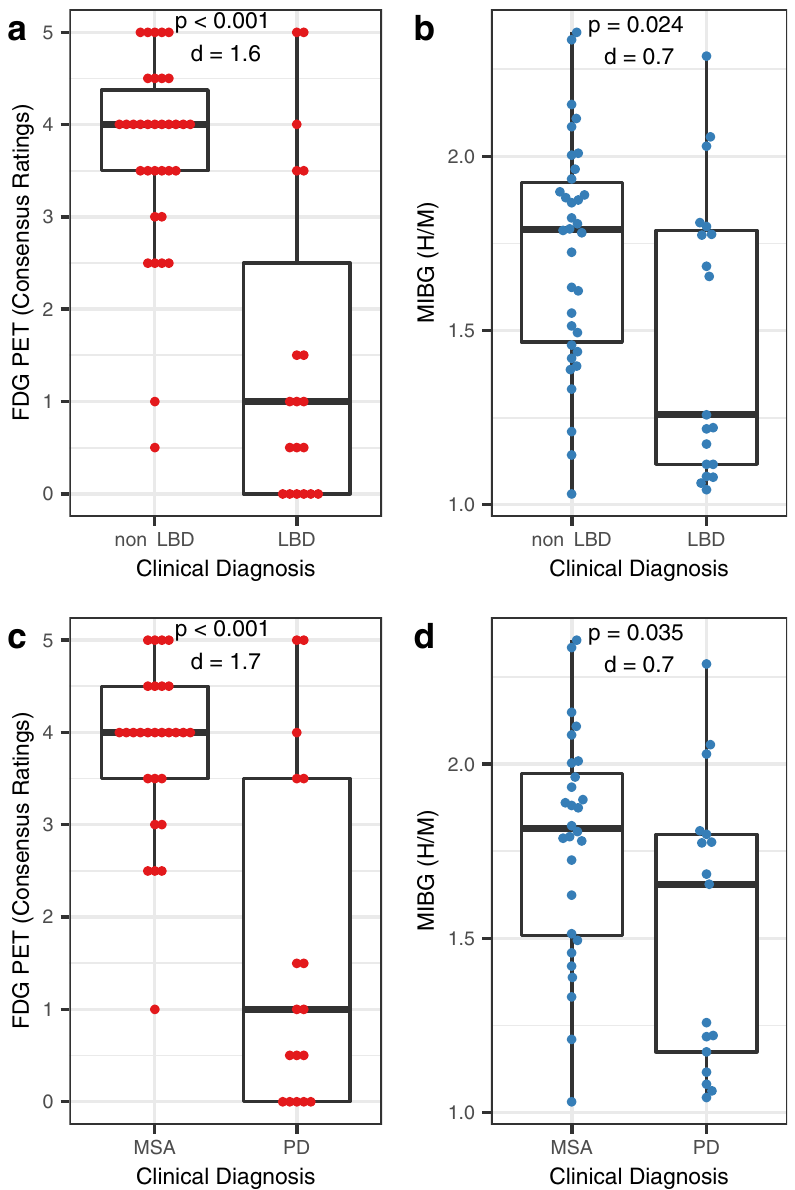
Fig. 1 Boxplots for FDG PET and MIBG scintigraphy. a FDG PET and b MIBG scintigraphy in the differentiation of Lewy body diseases and diseases without Lewy bodies. c FDG PET and d MIBG scintigraphy in the differentiation of multiple system atrophy and Parkinson ’ s disease. Center line, median; box limits, upper and lower quartiles; whiskers, 1.5 × interquartile range; p values refer to Mann – Whitney U -test, d values to Cohen ’ s effect size. non LBD disease without Lewy bodies, LBD Lewy body disease, H/M heart-to-mediastinum ratio, MSA multiple system atrophy, PD Parkinson ’ s